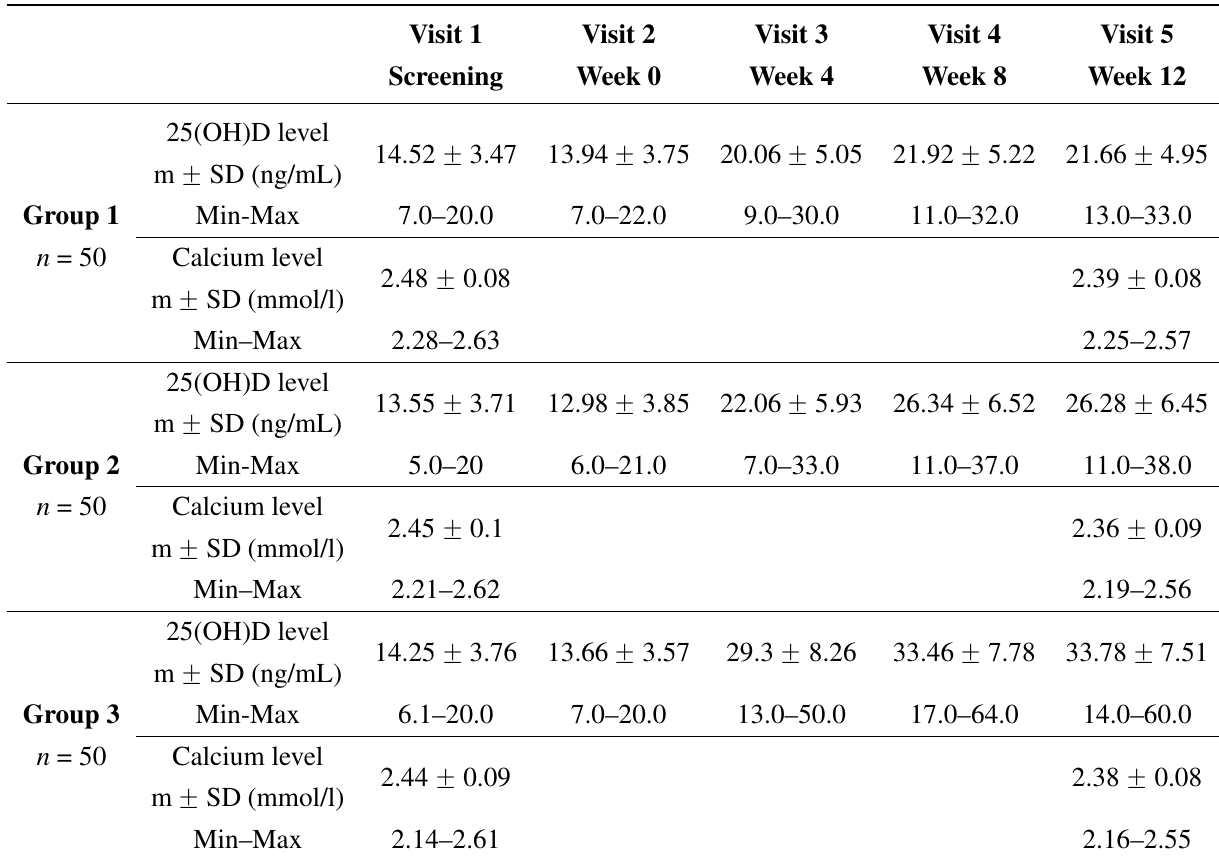
Table 4. Evolution of 25(OH)D (ng/mL) and calcium (mmol/L) serum concentrations over time. Visit 1 Visit 2 Visit 3 Visit 4 Visit 5 Screening Week 0 Week 4 Week